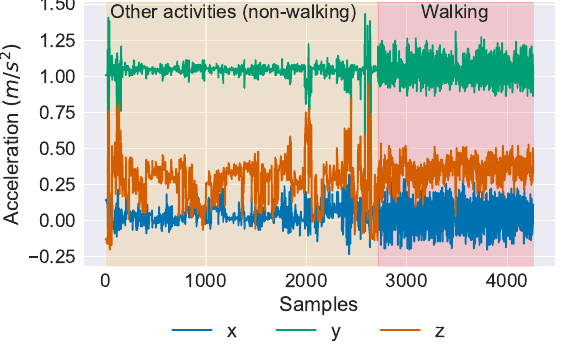
Figure 2. An example of collected accelerometer time series data for one of the subjects (#18). The other activities (non-walking) and walking parts for this specific subject are highlighted in yellow and red, respectively.